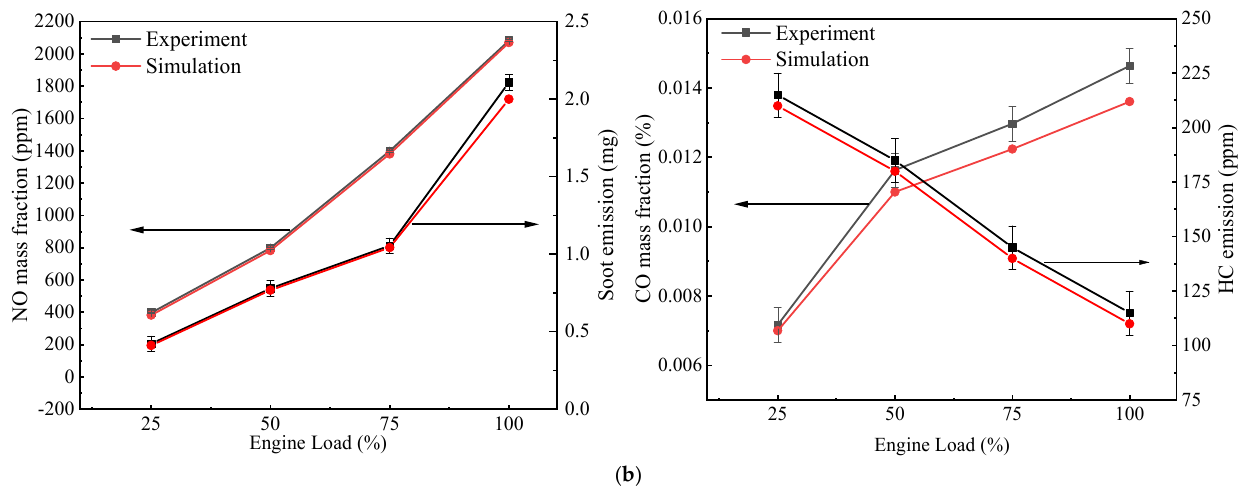
Figure 7. Comparisons of emissions (CO, Soot, HC, and NO x ) of ( a ) D100 and ( b ) BE10. ( a ) D100 emissions validation. ( b ) BE10 emissions validation.